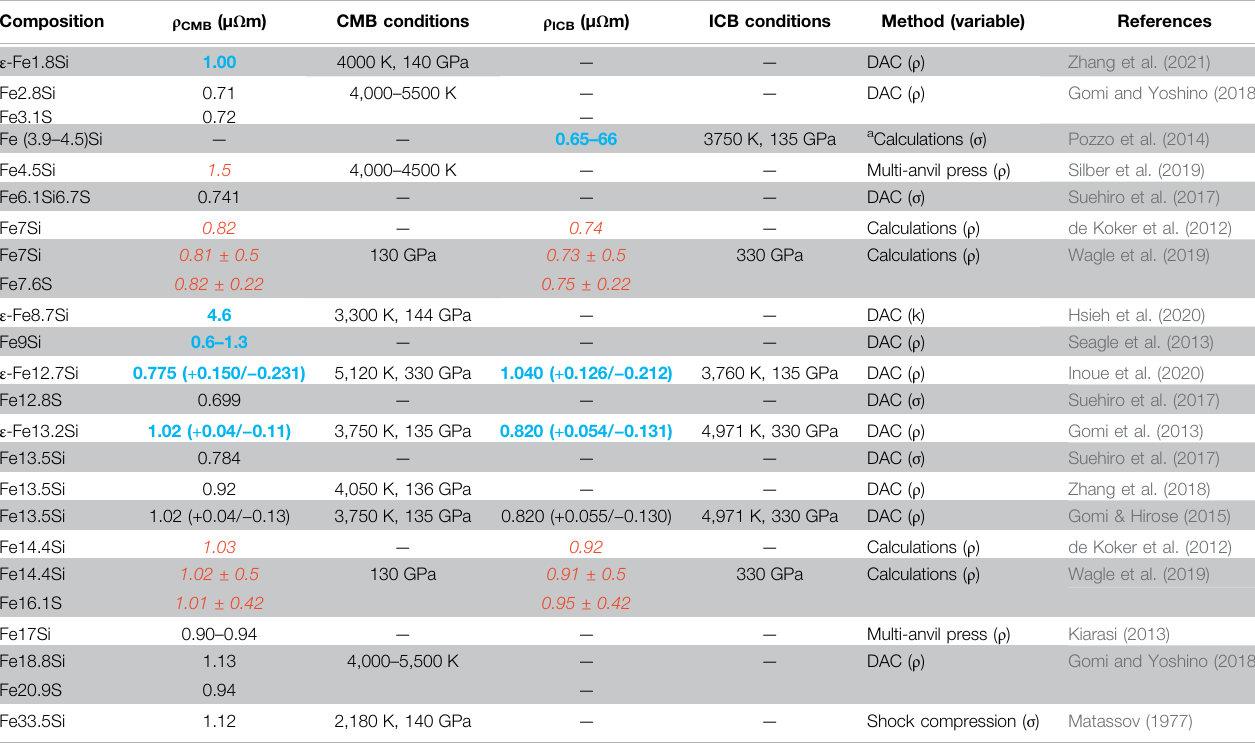
TABLE 4 | Electrical resistivity values of Fe-Si/S alloys at Earth ’ s CMB (4000 K, 136 GPa) and ICB (5000 K, 330 GPa) conditions determined by different methods. Composition